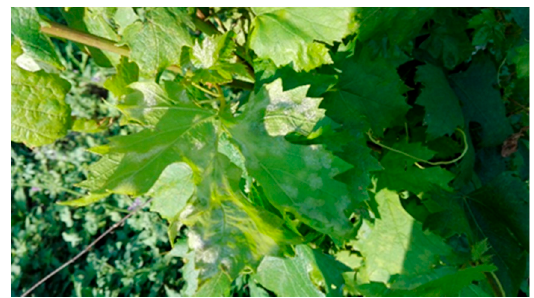
Figure 1. Grapevine affected by downy